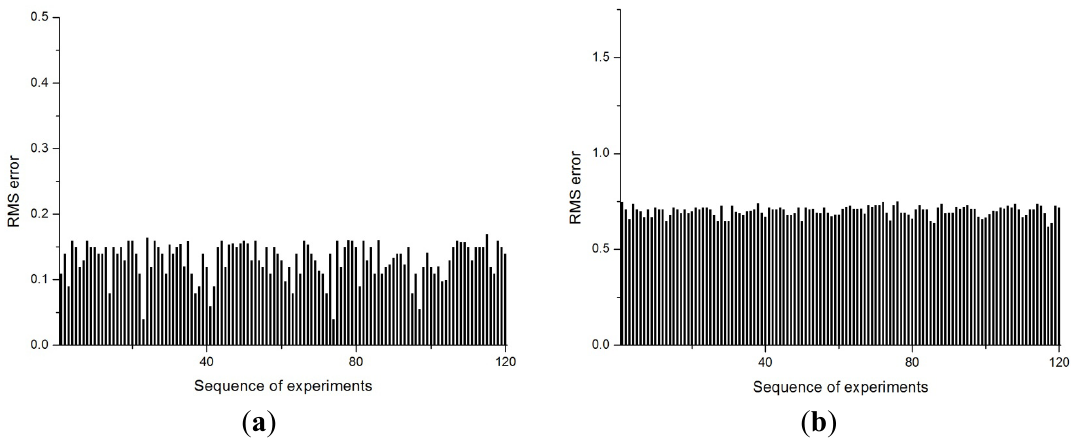
Figure 10. Repeated experiments of ( a ) the MLFN-3 for the prediction of heat collection rate and ( b ) the GRNN for the prediction of heat loss